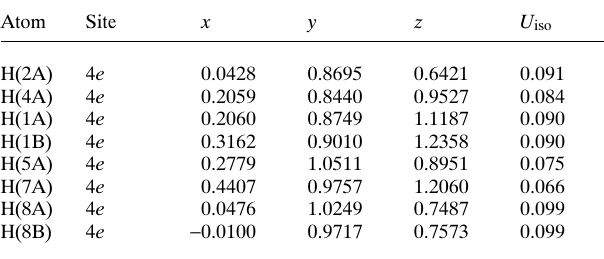
Table 2. Atomic coordinates and displacement parameters (in Å 2 )